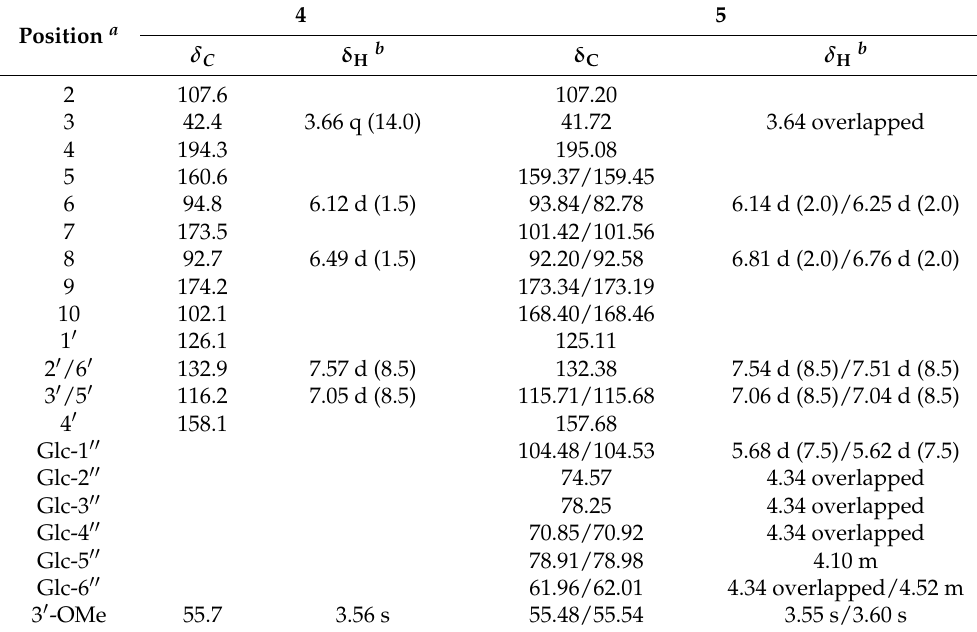
Table 2. 1 H- and 13 C-NMR spectroscopic data of compounds 4 and 5 ( δ in ppm, pyridine- d 5 , 500 MHz, and 125